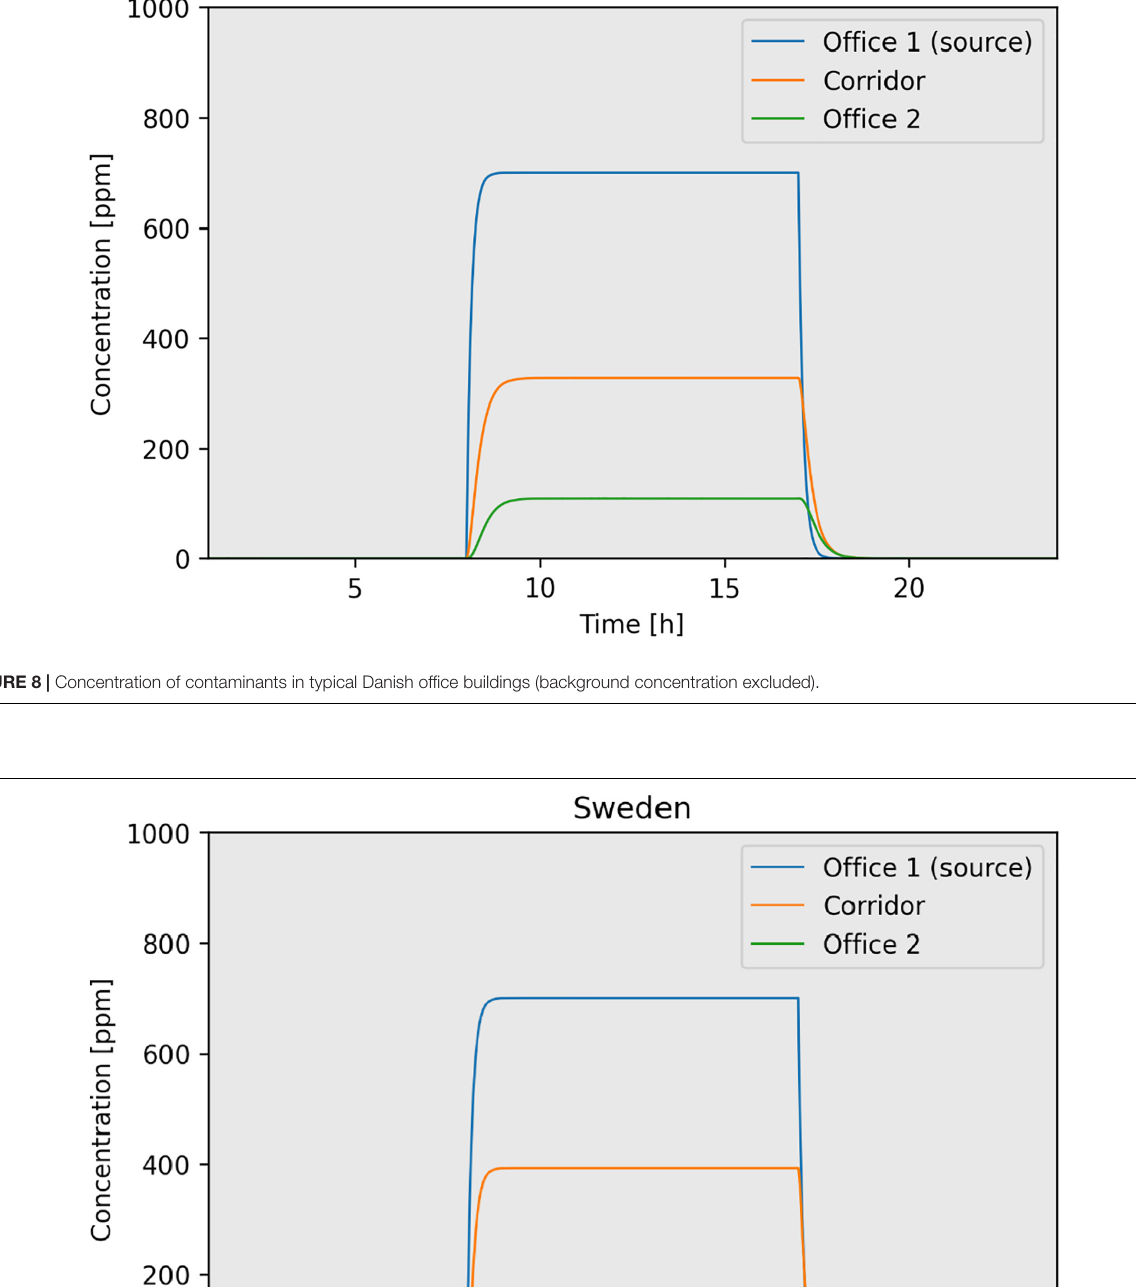
Frontiers in Built Environment |